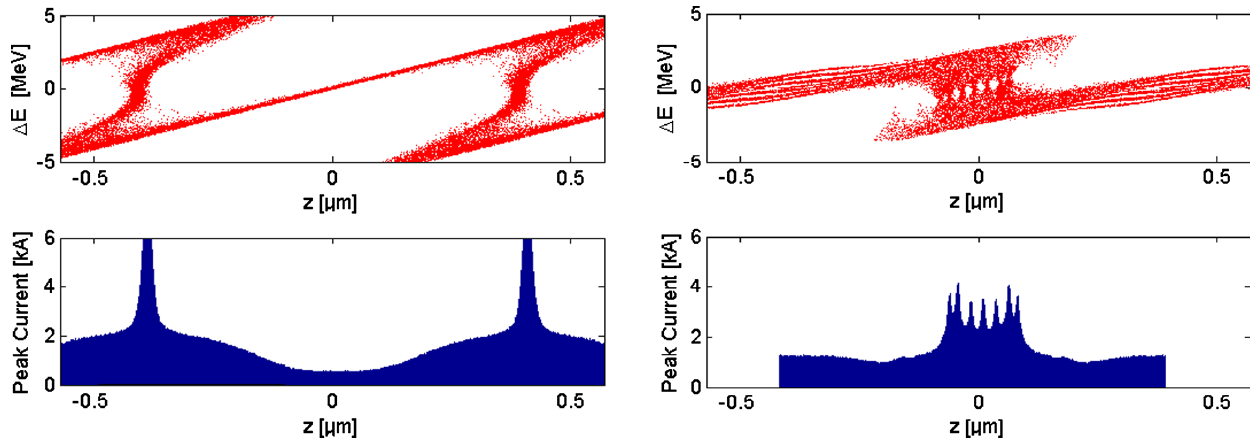
nm.FIG. 4. 3D longitudinal phase space after last chicane for LSC-EEHG seeded (right) and lasing suppressed (left) portions of the beam. Seeding was done with 800 nm in the tails (left) and with a combination of 800 nm and 266 nm in the central spike (right). The average beam radius in the 26 m drift section was 150 μ m (rms), the longitidutinal dispersion of the first and second chicanes was 485 μ m and 85 μ m, respectively, the initial peak current was 1.5 kA, and the beam energy was 900 MeV with a 150 keV (rms) initial slice energy spread. The initial energy modulation was 350 keV in the 800 nm background and 1 MeV in the 266 nm seeded region. The rms energy spread of the seeded portion is 1.5 MeV and the rms energy spread of the lasing suppressed portion is 4 (pp) energy modulation were used to do HGHG seeding [1] with a 10-m-long radiator, the bunching factor would become unusable above the 10th harmonic.